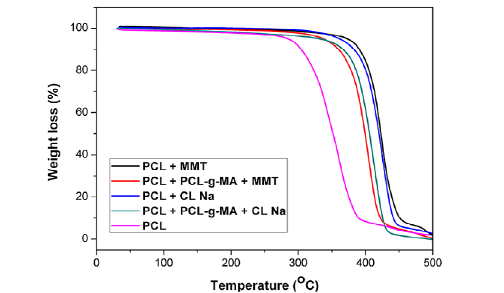
Figure 5. TG curves for PCL compounds.